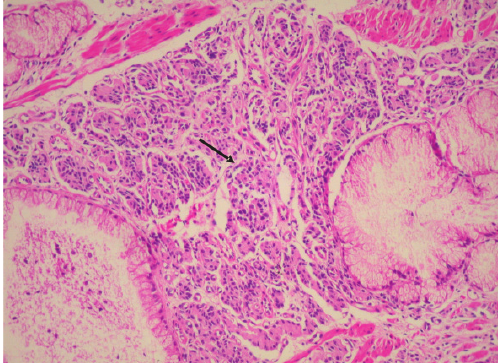
Figure 5- Photomicrograph of somatostatinoma of the minor papilla. The tumor is composed of nests of uniform cells (arrow) forming a trabecular pattern, eosinophilic granular cytoplasm, and the typical organoid arrangement of neuroendocrine cells. The nuclei are small and show fine chromatin (salt-pepper chromatin). (hematoxylin & eosin staining; original magnification ×